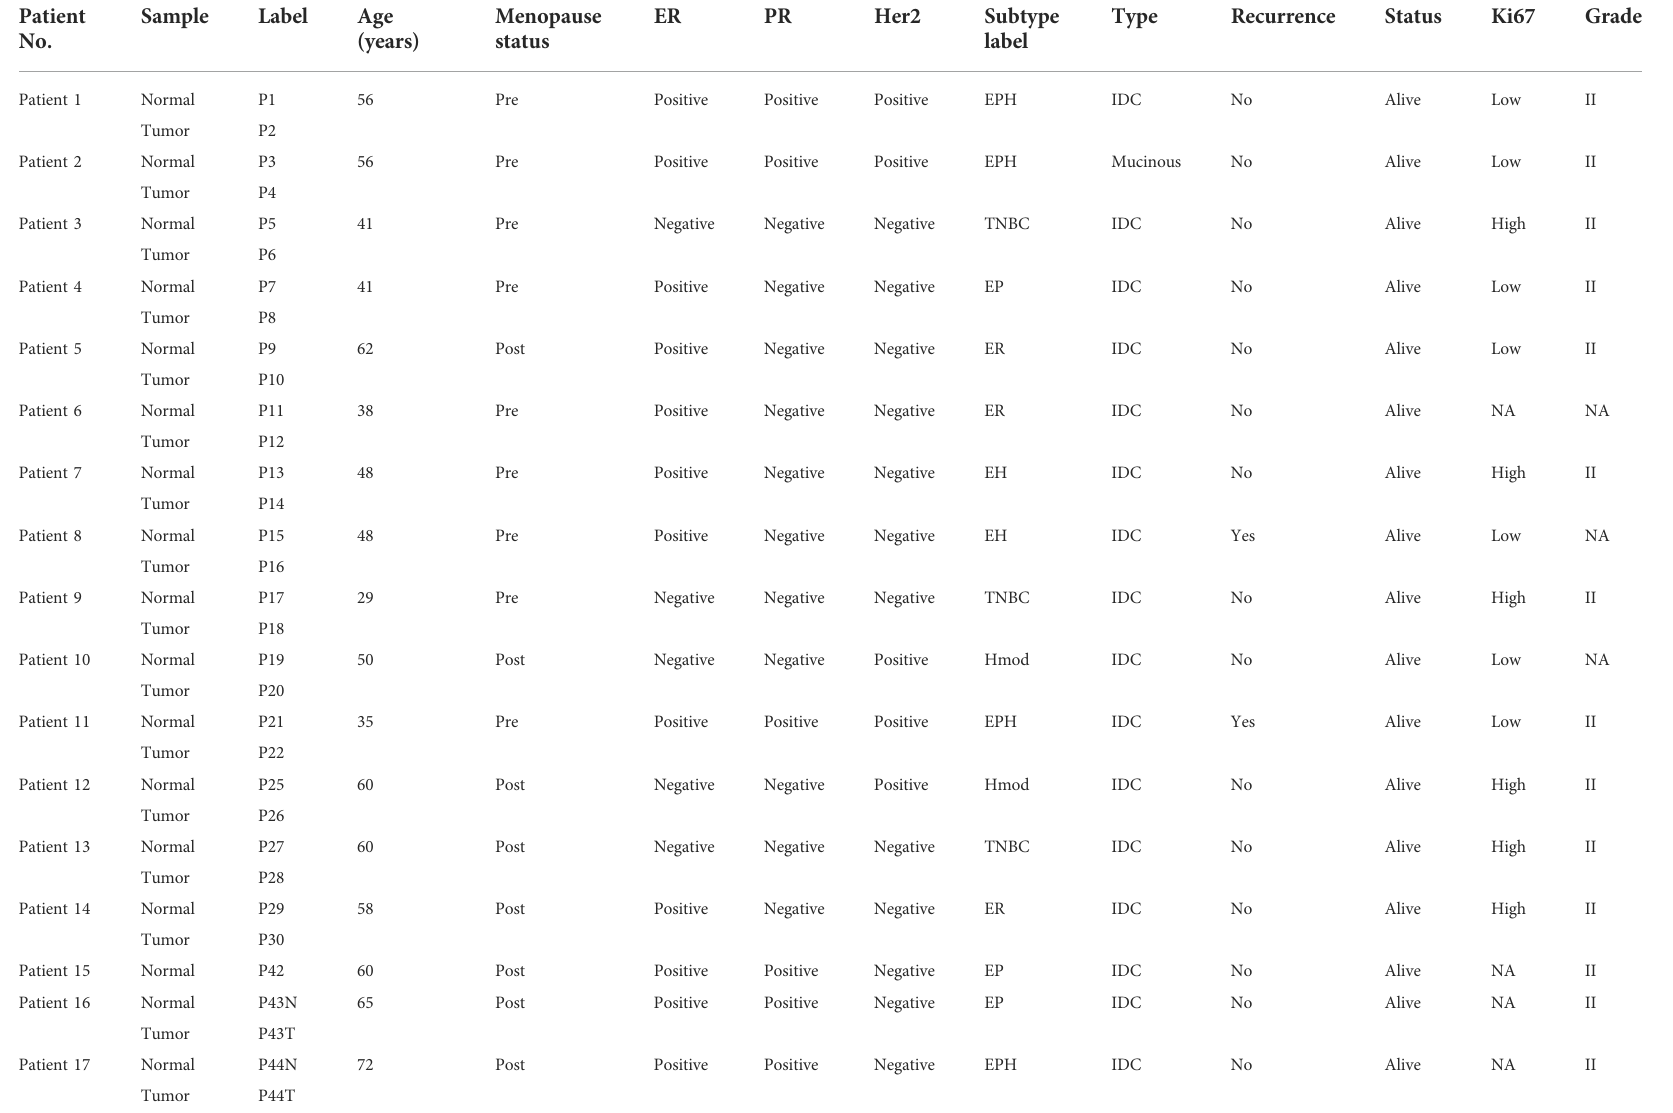
TABLE 1 Table depicting sample details of Indian breast cancer patients. Odd numbers are matched normals and even numbers are tumor samples. There are a total six subtypes (ER, EH, EP, EPH, Hmod, and TNBC) classi fi ed based on the expression of estrogen receptor (ER), progesterone receptor (PR), and epidermal growth factor receptor (Her2). IDC, invasive ductal carcinoma. Patient